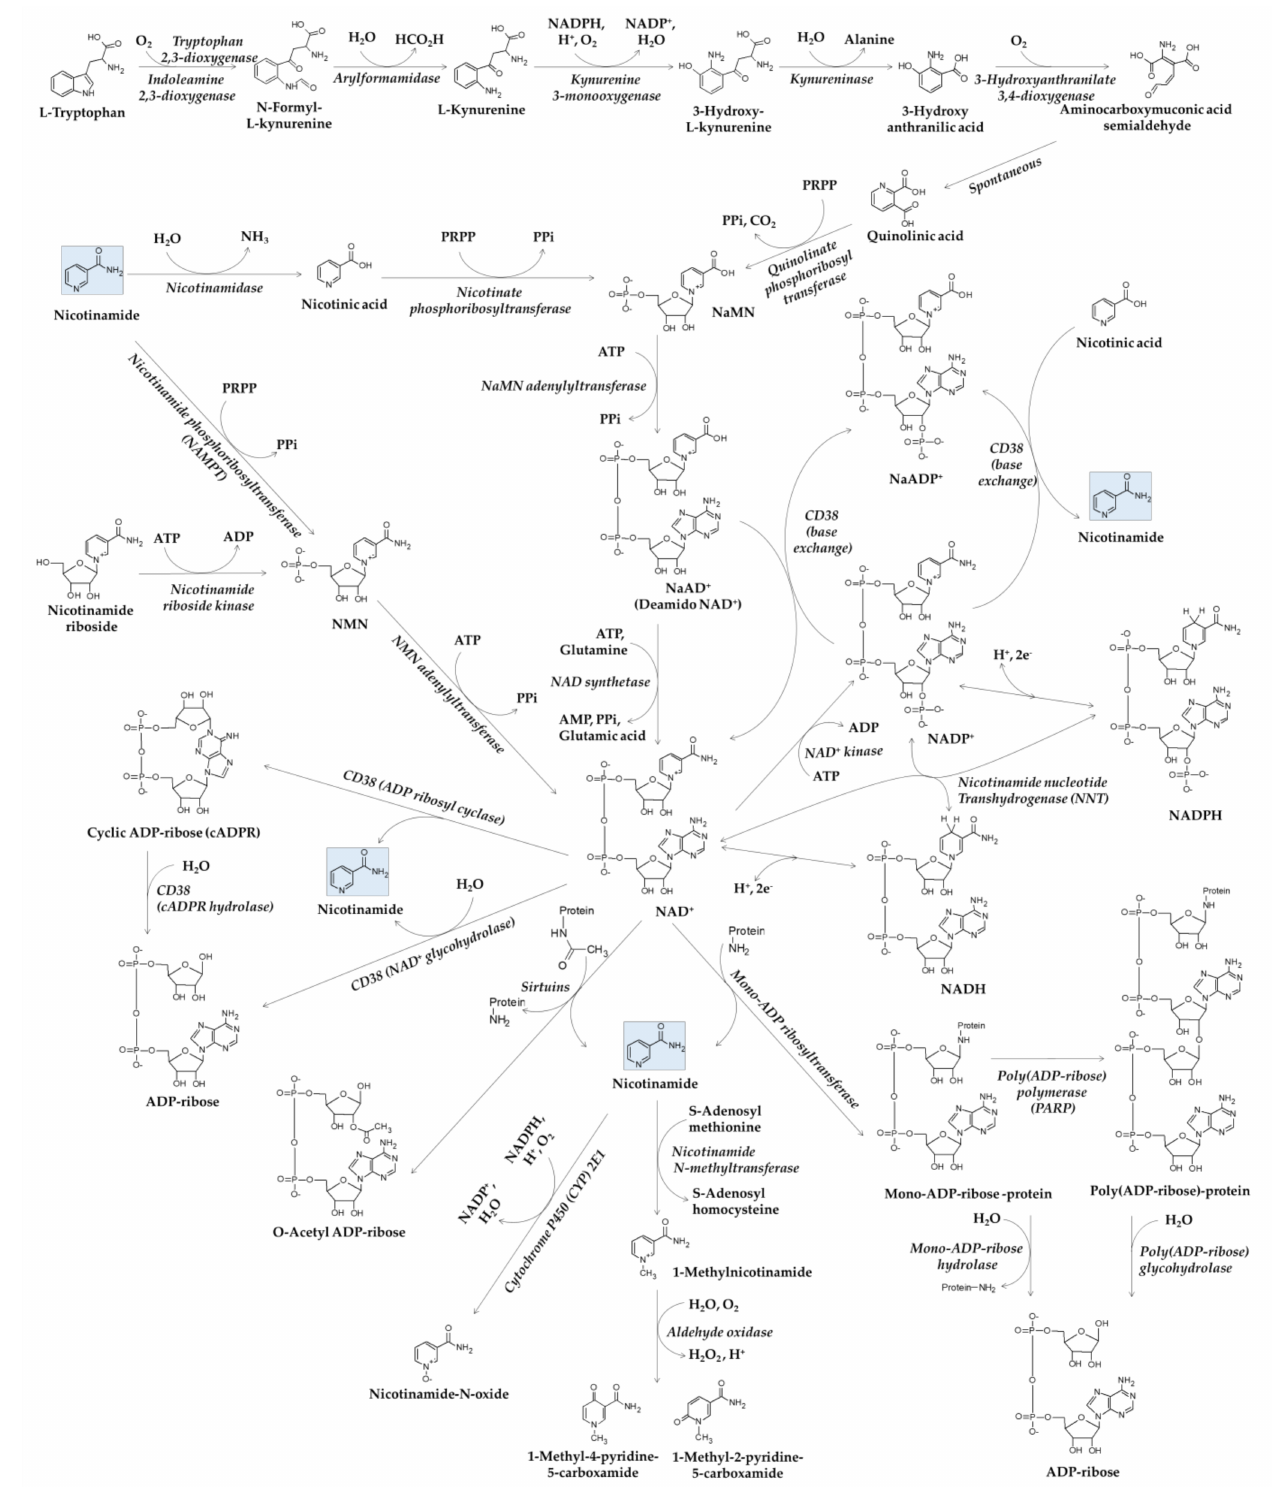
Figure 1. Metabolic pathways related to nicotinamide: ADP, adenosine diphosphate; AMP, adenosine monophosphate; ATP, adenosine triphosphate; cADPR, cyclic ADP-ribose; CYP, cytochrome P450; NaAD + , nicotinic acid adenine dinucleotide; NaADP + , nicotinic acid adenine dinucleotide phosphate; NAD + , nicotinamide adenine dinucleotide; NADH, reduced nicotinamide adenine dinucleotide; NADP + , nicotinamide adenine dinucleotide phosphate; NADPH, reduced nicotinamide adenine dinucleotide phosphate; NaMN, nicotinic acid mononucleotide; NAMPT, nicotinamide phosphoribosyltrans- ferase; NMN, nicotinamide mononucleotide; NNT, nicotinamide nucleotide transhydrogenase; PARP, poly(ADP-ribose) polymerase; PPi, inorganic pyrophosphate; PRPP, phosphoribosyl